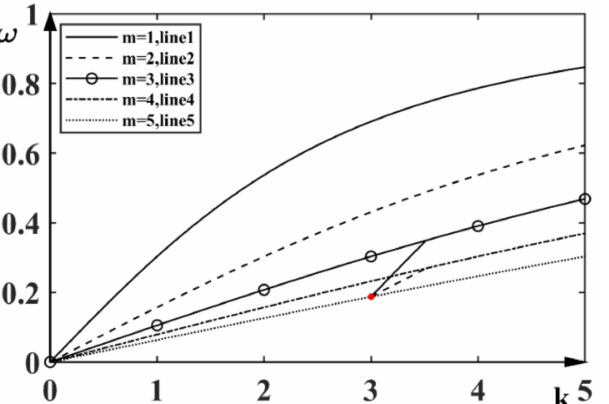
Figure 1. Schematic diagram of coupled triads with all five participating waves traveling in the same direction. A solid dot on the m = 5 branch represents the common member, with modes 1, 3, and 5 forming one triad and modes 2, 4, and 5 the other triad. As an illustrative example, the numerical values of the corresponding wave numbers and wave frequencies are: ( k 1 = 0.5153, ω 1 = 0.1619), ( k 2 = 0.5160, ω 2 = 0.0819), ( k 3 = 3.5153, ω 3 = 0.3495), ( k 4 = 3.5160, ω 4 = 0.2694), ( k 5 = 3, ω 5 = 0.1876). The wave number k is defined as usual by the number of waves in a length of 2 π